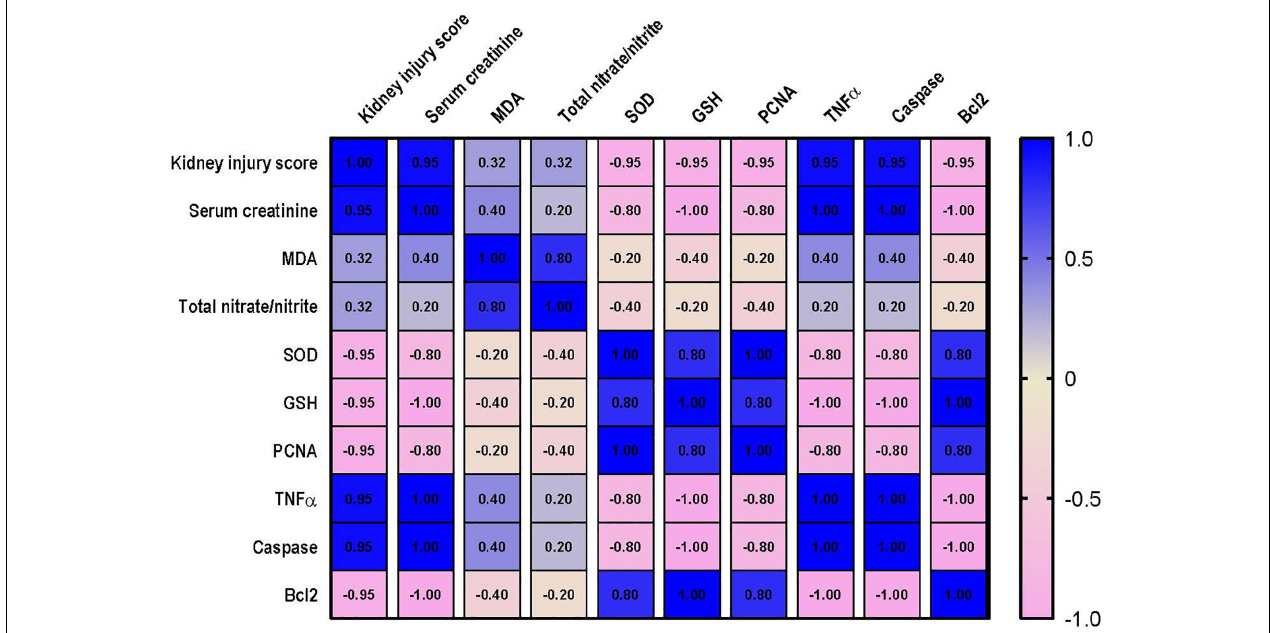
FIGURE 11 | Correlation analysis of Kidney injury and measured parameters. Correlation matrix between kidney injury score and related parameters. Data from different experiments were analyzed for correlation using the Pearson correlation coefficient (r). Positive values indicate a positive correlation while negative values indicate a negative one. When r is in the range of | 0.3| –| 0.7|, this indicates a moderate correlation, and when r > | 0.7|, this means a strong correlation. MDA, malondialdehyde; SOD, superoxide dismutase; GSH, reduced glutathione; PCNA, proliferating cell nuclear antigen; TNF– α , tumor necrosis factor α ; Bcl2, B cell lymphoma 2.